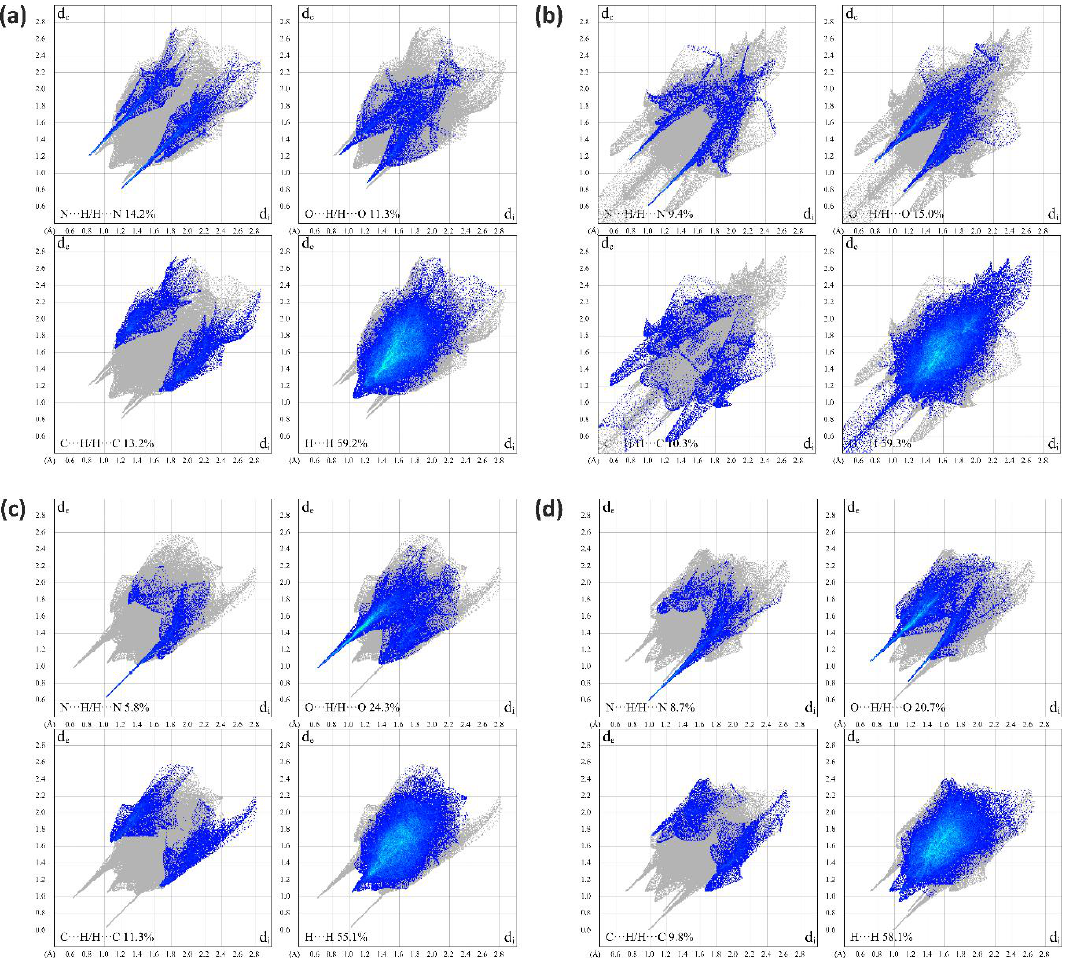
Figure 8. Two-dimensional fingerprint plots of ( a ) TAF, ( b ) 1 , and ( c , d ) 2 , showing that the plots of